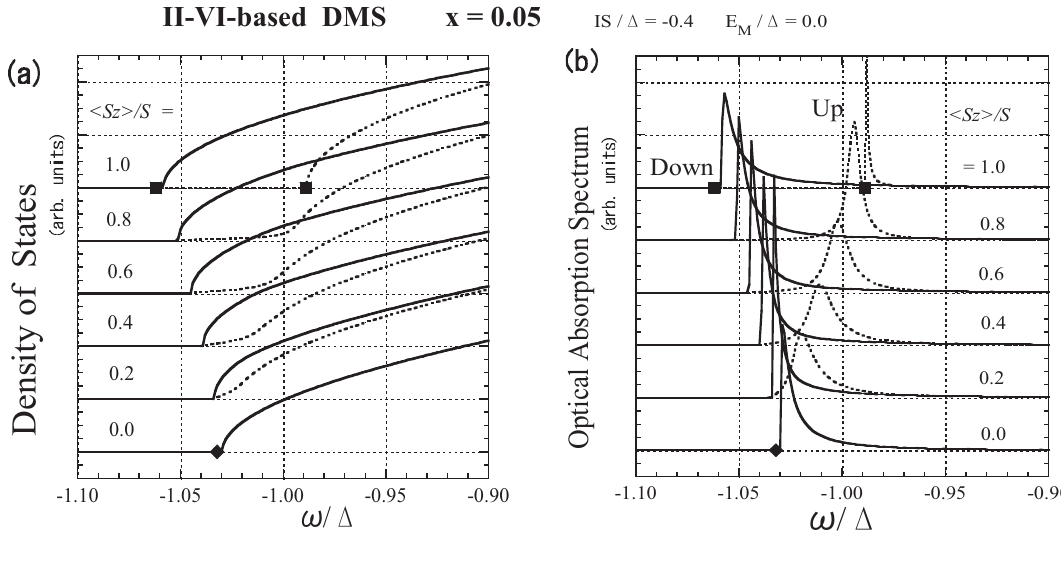
D ( ! ) . (b) Optical absorption spectrum A ( ! ) in arbitrary units (arb. units). The solid lines represent the down-spin carrier and the dotted lines represent the up-spin carrier. The values of the band-edge energy, ! simple approximation are plotted as dots on the lines of ⟨ S (see text). Note that the energy of the bottom of the model band is ! = − ∆ . From Takahashi